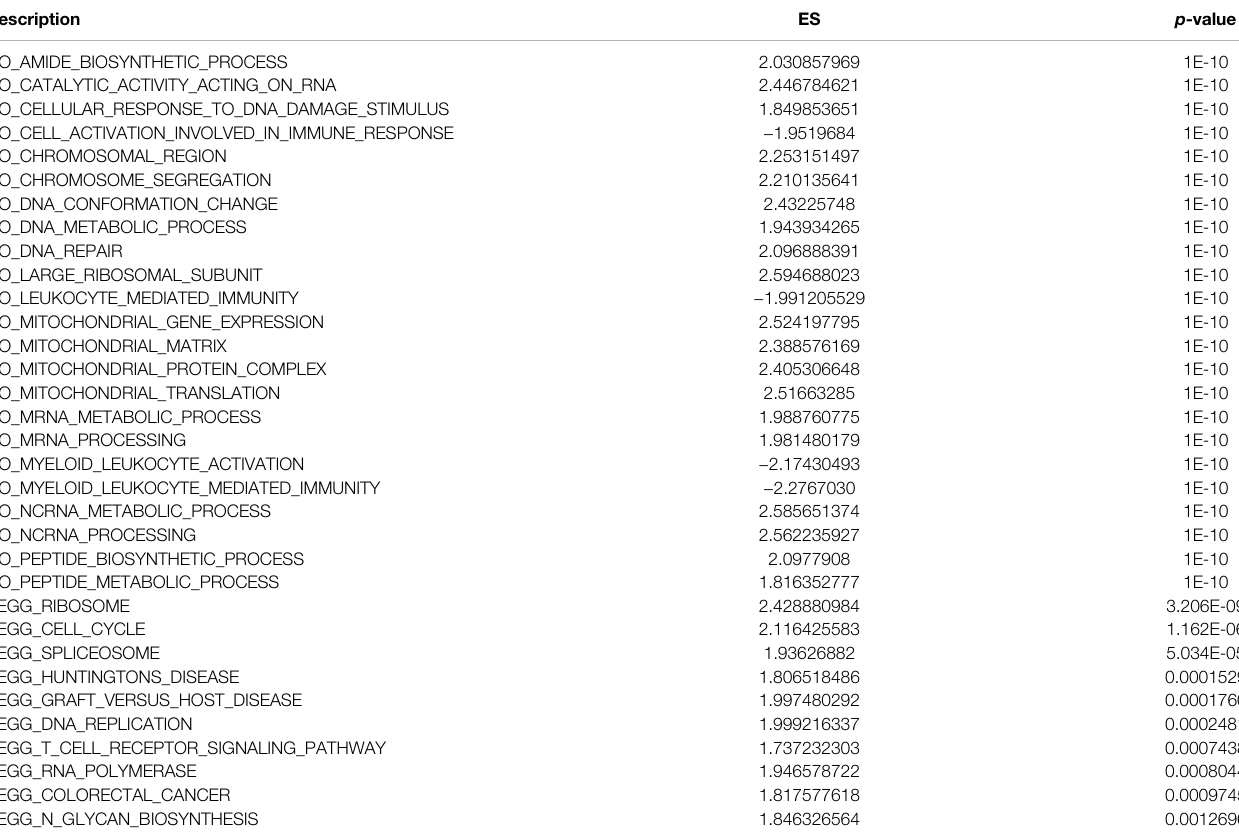
TABLE 5 | GSEA enrichment analysis of the GSE124272 dataset.